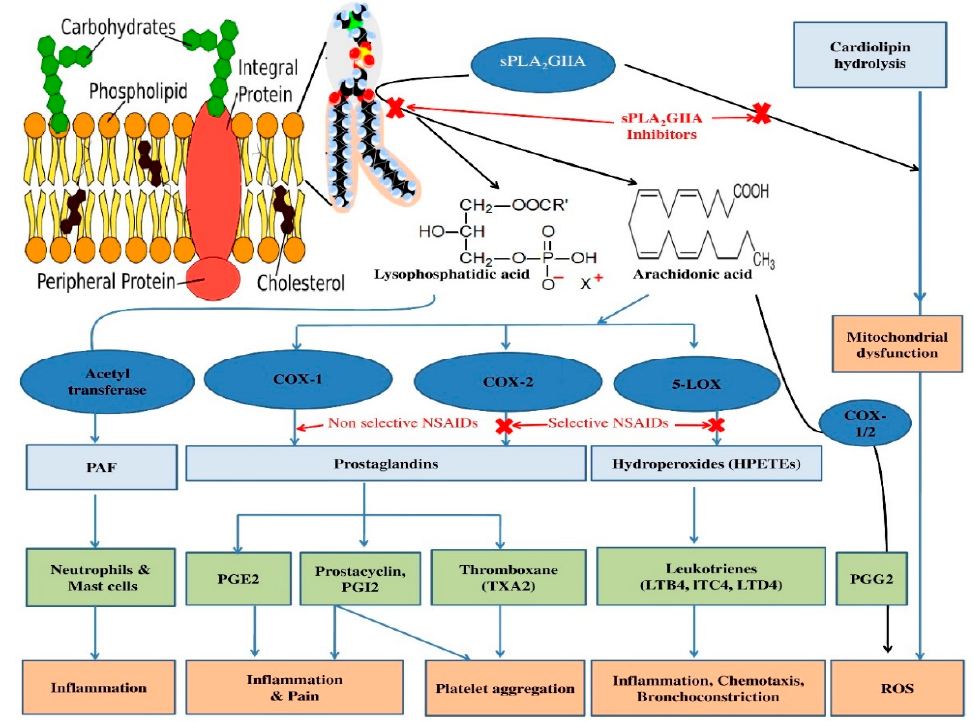
Figure 1. Schematic representation of sPLA 2 -IIA mediated inflammatory pathways, ROS production and check points of anti-inflammatory molecule/drugs.